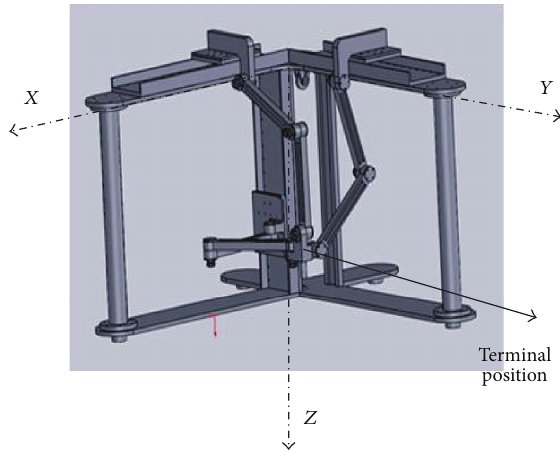
Figure 1: Picture of translational platform under SolidWorks.